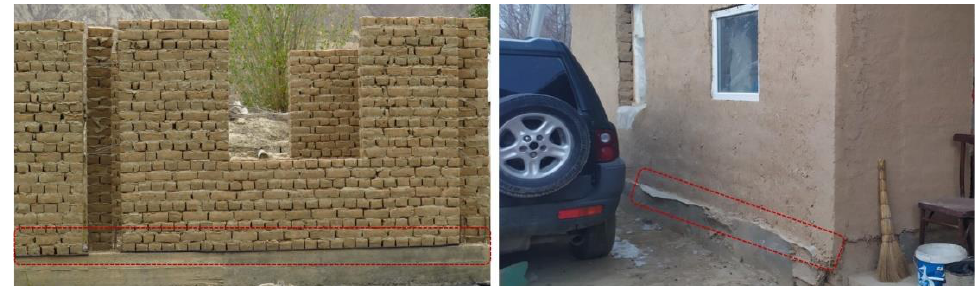
Figure 15. Provision of vapour barrier to avoid water diffusion on walls.